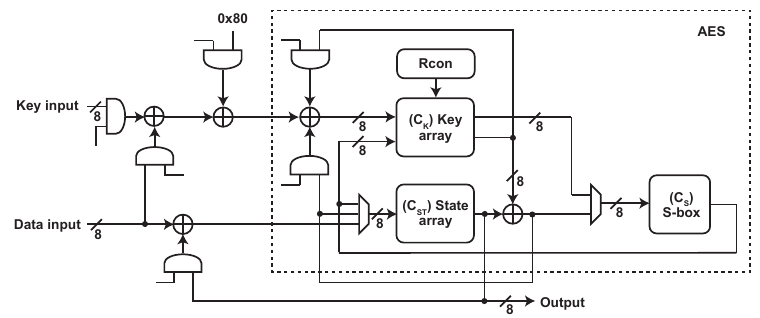
Figure 7: Datapath diagram of the AES - LBBB hardware implementation